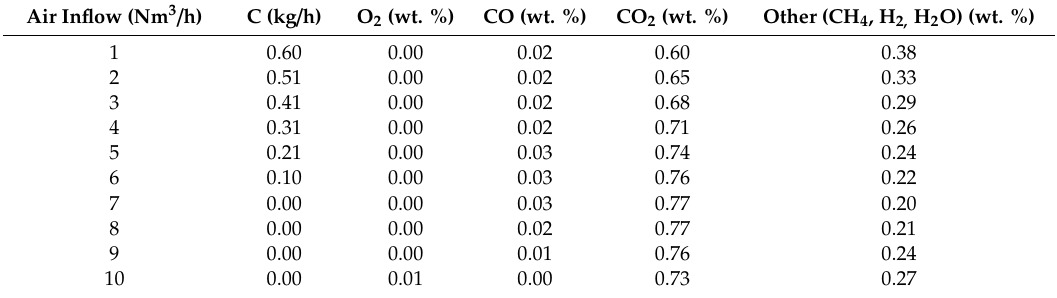
Table 3. Simulation of co-incineration of 60 wt. % rice straw / 40 wt. % wood pellets (N 2 -free basis). Air Inflow (Nm 3 /